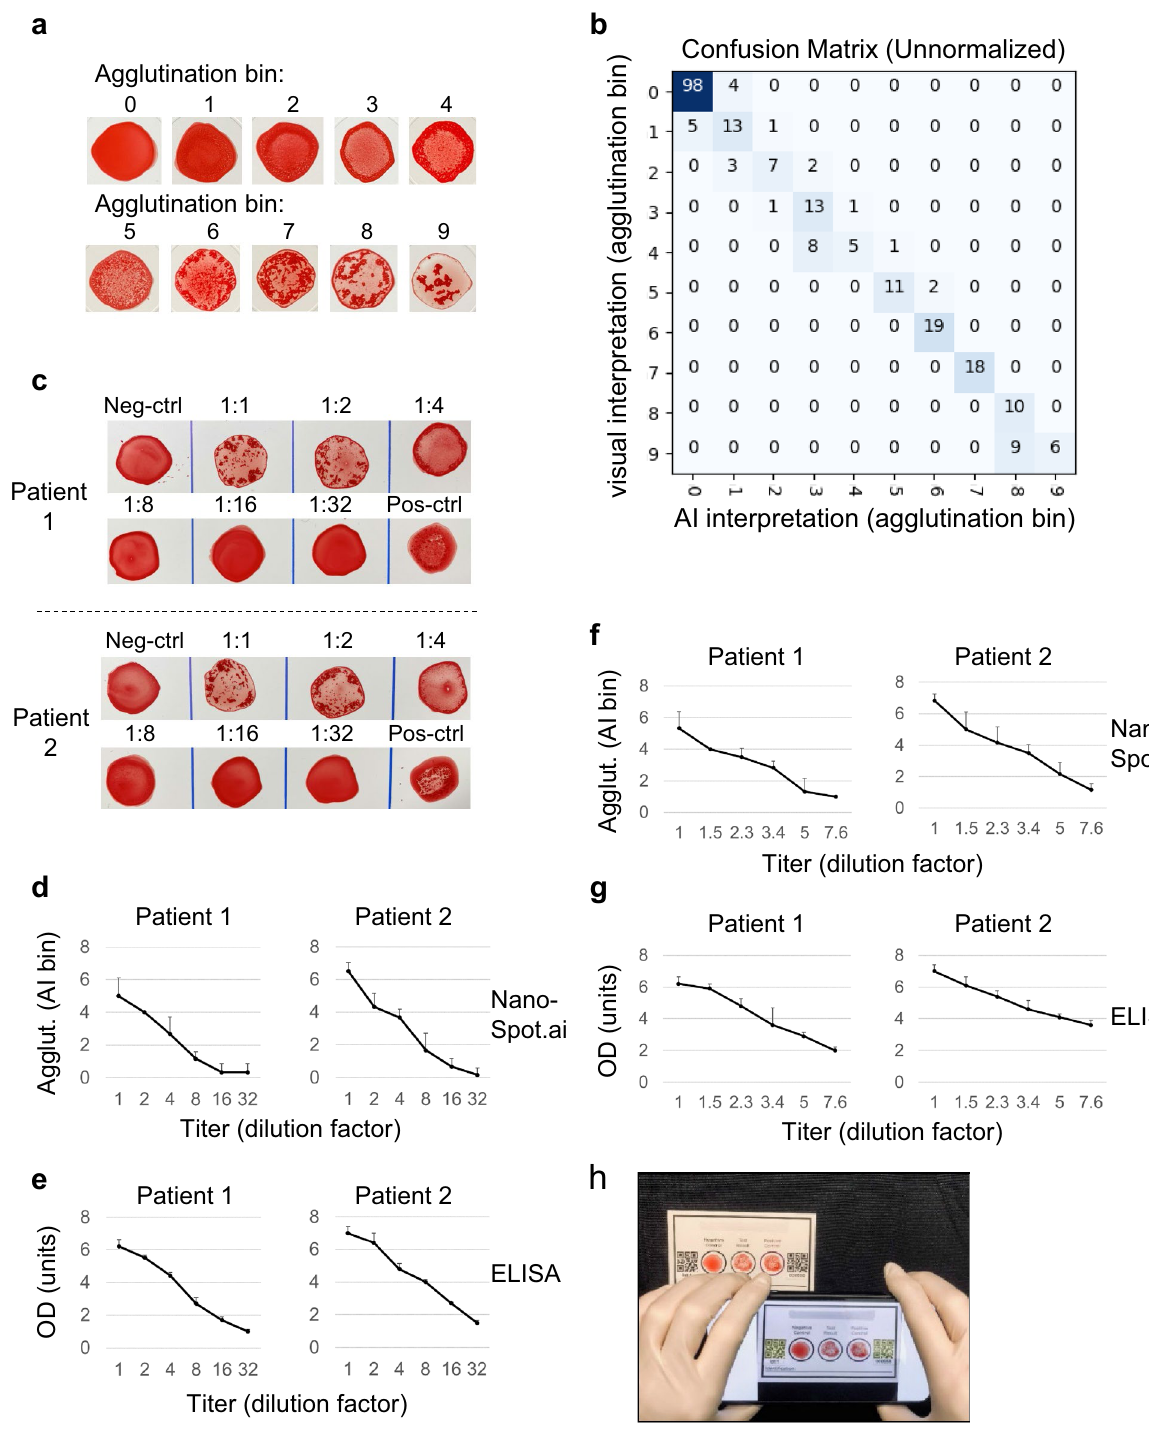
Figure 6. Quantitative assessment of hemagglutination titers using NanoSpot.ai. ( a ) Master palette of hemagglutination samples selected based on visual appearance and reflecting a range of agglutination from 0 (no agglutination) to 9 (strongest agglutination). ( b ) Confusion matrix based on visual and AI-based interpretation of agglutination samples (holdout set), which had not been shown to AI before. ( c – g ) Correlation of AB-titer with visual appearance of hemagglutination ( c ), AI-based interpretation ( d , f ) and ELISA ( e , g ). Serum samples of two COVID-19-positive patients were titrated (in COVID-19-negative serum) and analyzed by indicated methods. Agglutination was terminated when close to fully developed (corresponding to AI-bin 6–8). twofold ( c – e ) and 1.5-fold ( f , g ) dilution steps were used as indicated. Error bars represent mean ± Std dev based on six ( d , f (AI)) or three ( e , g (ELISA)) replicates. ( h ) Setting used for data acquisition, including test card, cell phone and mobile app capturing